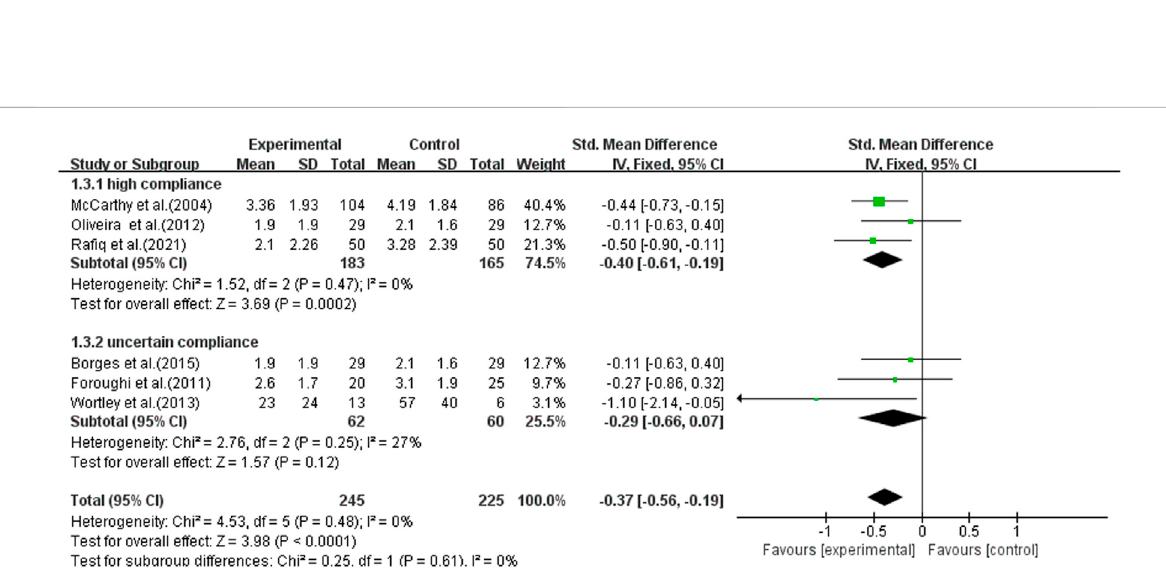
FIGURE 9 Forest plot of comparison: high versus uncertain, outcome: 1.3 Stiffness (WOMAC). Effect of land-based exercise compared to control when stiffness outcomes were assessed using the WOMAC stiffness subscale. Data are presented as standardized mean differences, with differences < 0 favoring land-based exercise. Subgroup analysis showed that the high-compliance group [SMD − 0.40 (95% CI − 0.61, − 0.19), I 2 = 0%] ( p < 0.001) showed signi fi cant improvement in stiffness measures and the uncertain-compliance group [SMD − 0.29 (95% CI − 0.66, 0.07), I 2 = 27%] ( p = 0.120) did not. Subgroup analysis showed similar effects for pain in the high-compliance group [SMD − 0.21 (95% CI − 0.38, − 0.05), I 2 = 0%] ( p = 0.010) and those with the uncertain-compliance group [SMD − 0.61 (95% CI − 0.82, − 0.40), I 2 = 49%] ( p <